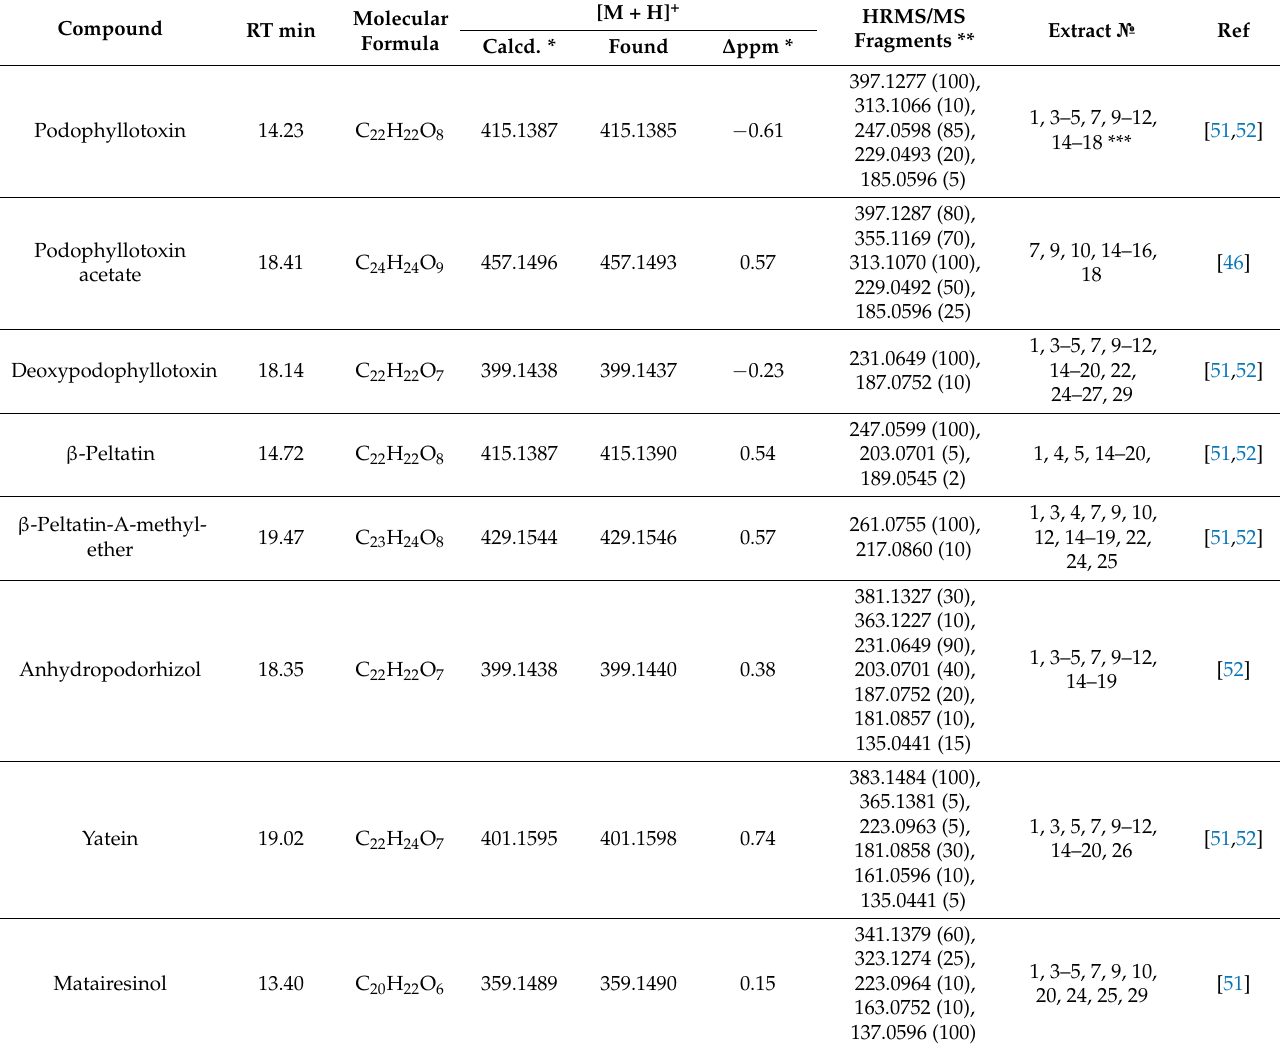
Table 4. HRMS/MS analysis of lignans, identified in cytotoxic juniper leaf